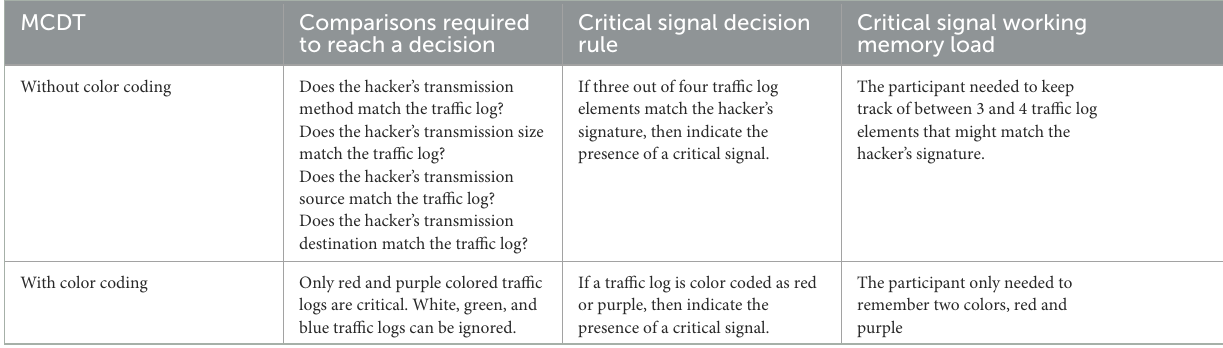
TABLE 1 Comparison of the MCDT with and without color coded signals.